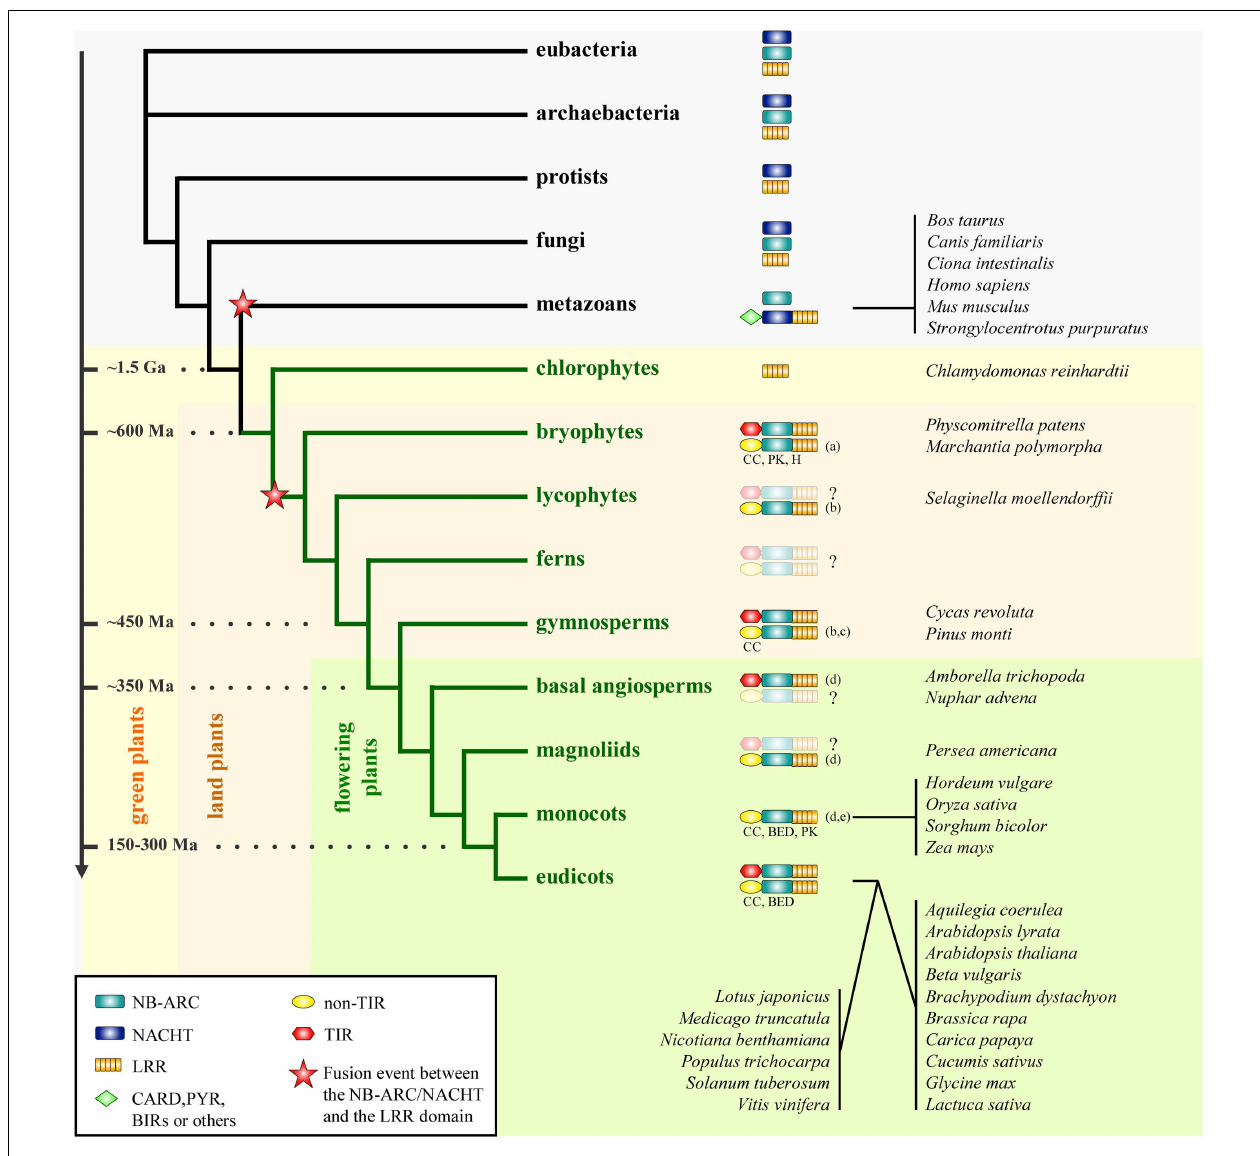
more detail, see Atypical Domains Found in the NLR Structure).This figure is adapted fromYue et al. (25), combined with data as indicated below.The divergence dates are adapted from Ref. (26) and (27). Species representative of some taxa are indicated on the right. Ma, million years; Ga, billion years.The question mark (?) indicates that the presence of NLRs is not clearly resolved in given taxa due to lack of data. (a) Xue et al.